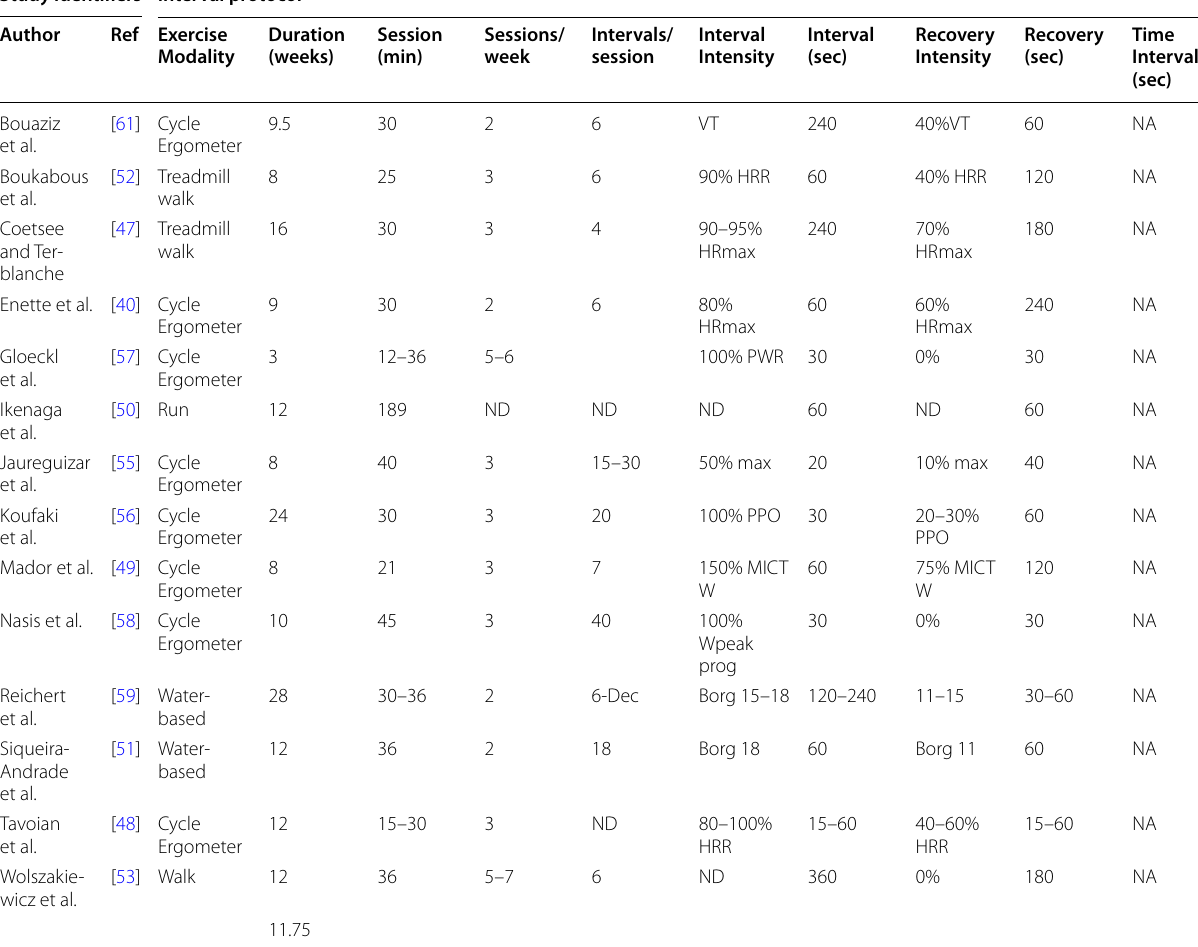
HIIT Versus MICT or Control: All Functional Movement Outcome Measures Treated as Separate Studies HIIT Versus MICT The effect of HIIT vs. MICT on functional movement outcomes was investigated in 12